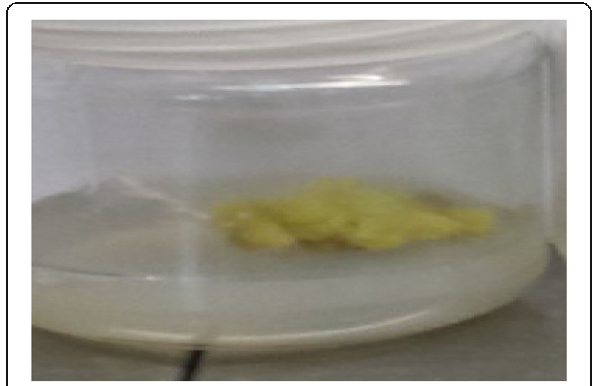
Fig. 2 Gardenia leaf calli produced on MS medium supplemented with 4 mg/l TDZ and incubated under light condition 16/8 h at 26 ± 1 °C for 4